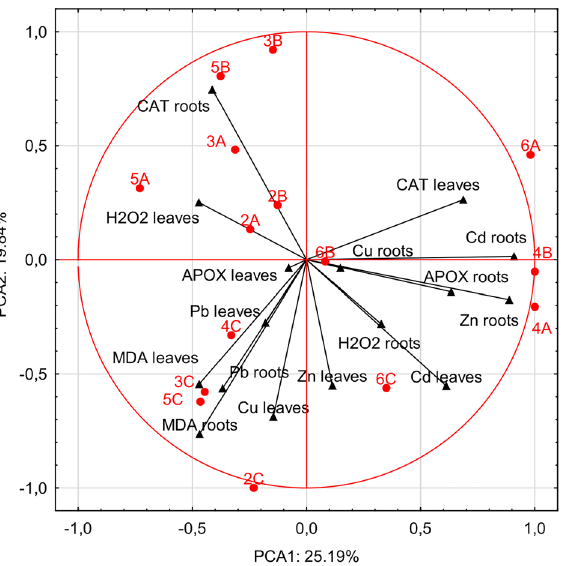
Figure 3. Principal component analysis of heavy metal concentration in examined samples (abbreviations see “Materials and methods”) in relation to hydrogen peroxide—H 2 O 2 , APOX, CAT, MDA